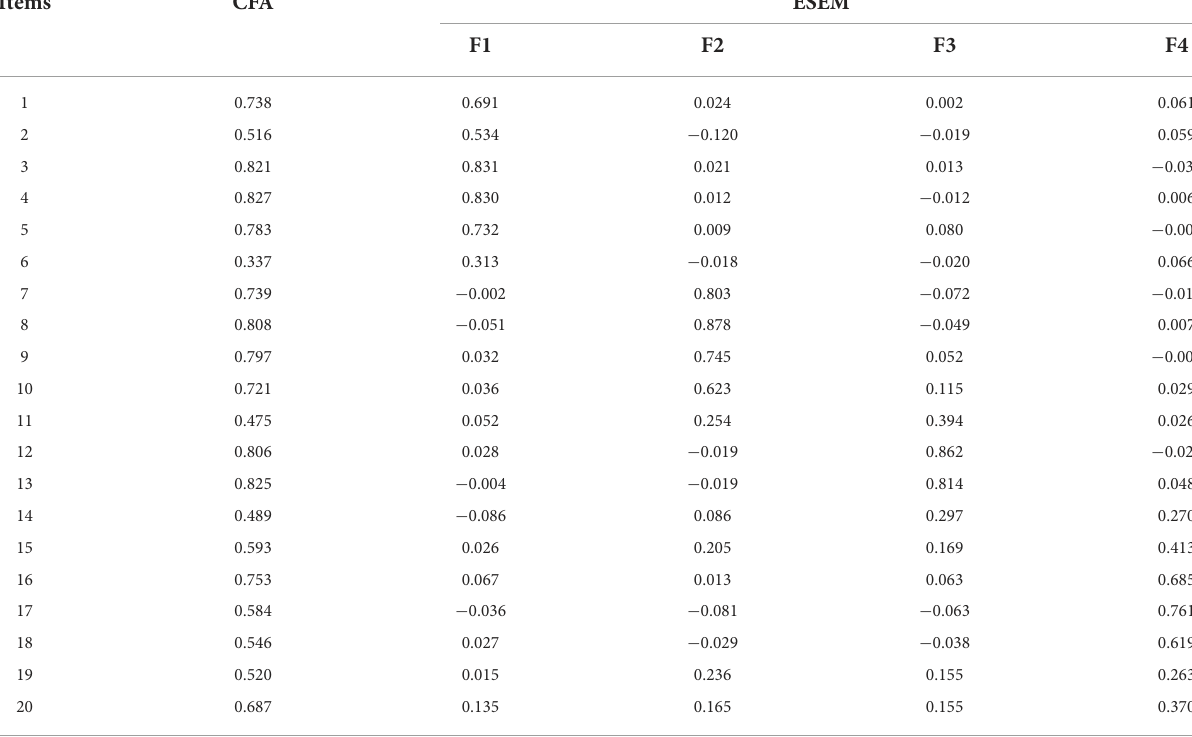
TABLE 4 Factor loading of the C19P-S-C items on CFA and ESEM model.